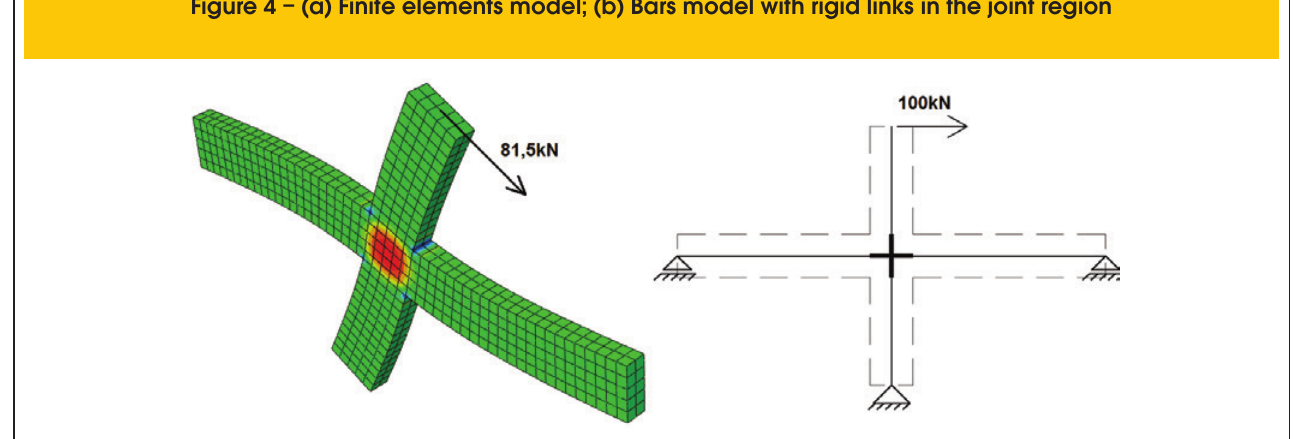
Figure 4 – (a) Finite elements model; (b) Bars model with rigid links in the joint